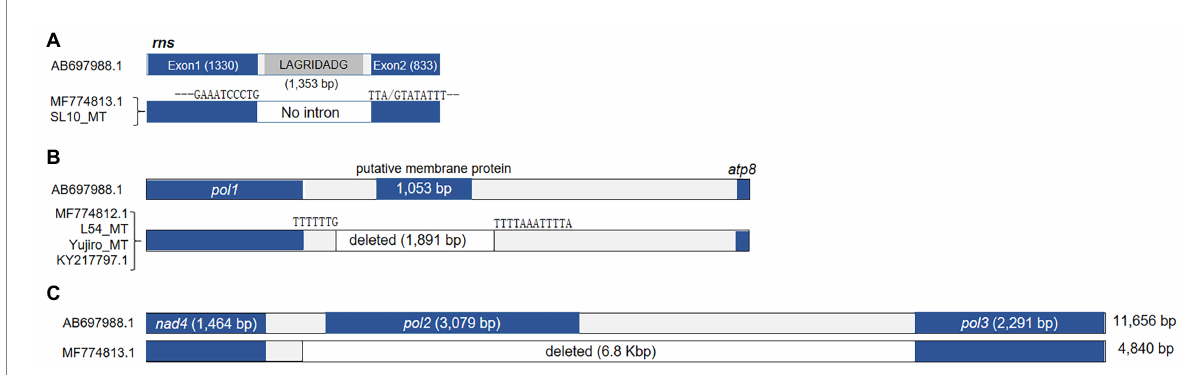
FIGURE 5 Sequence variations in rns and other deletions in the mtDNA. (A) The occurrence of intronless rns in MF774813.1 and SL10_MT. (B) Deletion of sequence region found in four mtDNAs. The deleted region contains a putative protein-coding gene. Domain analysis failed to find any conserved domain but the putative protein was predicted to be a membrane protein with 5 transmembrane domains. (C) A large deletion found from